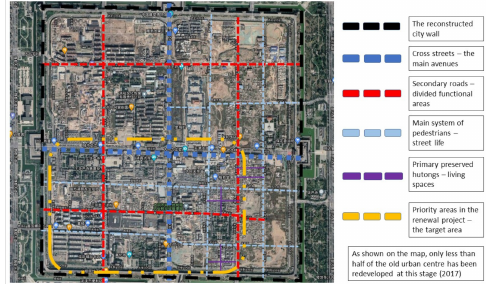
Figure 2. Selected locations of